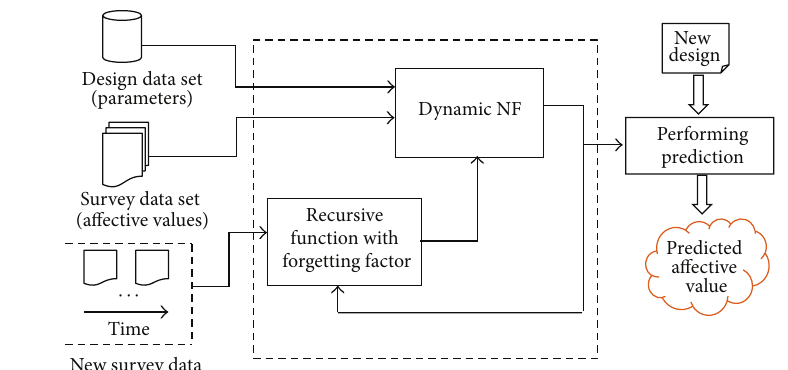
Figure 3: Decay of inference by the modified DENFIS.